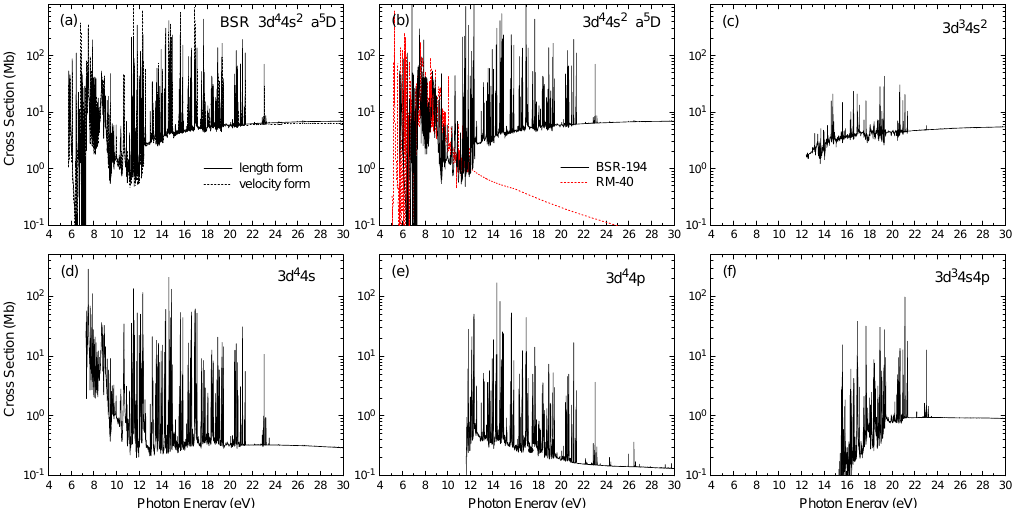
Figure 3. Total and partial photoionization cross sections from the excited 3 d 4 4 s 2 5 D state of Cr I as a function of photon energy. Panel ( a ) shows total cross sections from the present BSR-194 model in the length and velocity forms. Panel ( b ) compares the BSR-194 model with the RM-40 calculation of Nahar [14]. Panels ( c – f ) show summed partial cross sections for leaving the residual Cr II ion in final states of the 3 d 5 , 3 d 4 4 s , 3 d 4 4 p , and 3 d 3 4 s 4 p configurations, respectively.